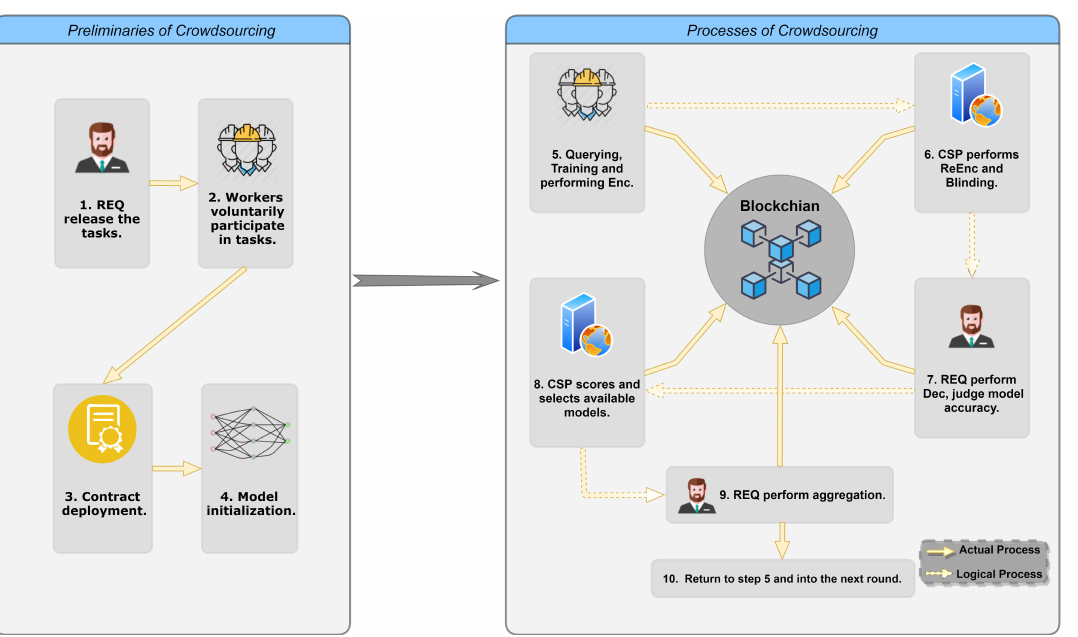
Figure 3. Overview of